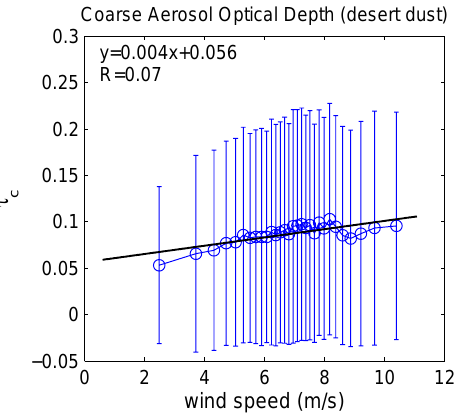
Fig. 2. MODIS-Aqua τ c plotted against AMSR-E W in an area dominated by desert dust (region DD in Fig. 1a). The data were sorted according to W and divided into 30 bins of equal number of observations. Points and error bars represent respectively the mean and standard deviation of τ c within each